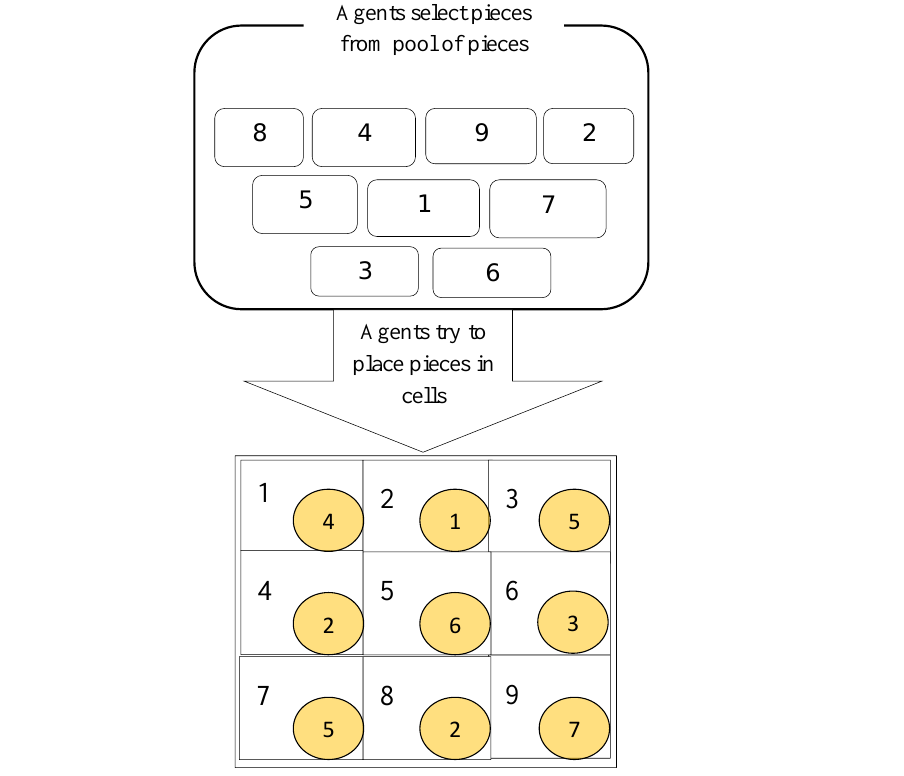
Figure 2. Multi-score puzzle